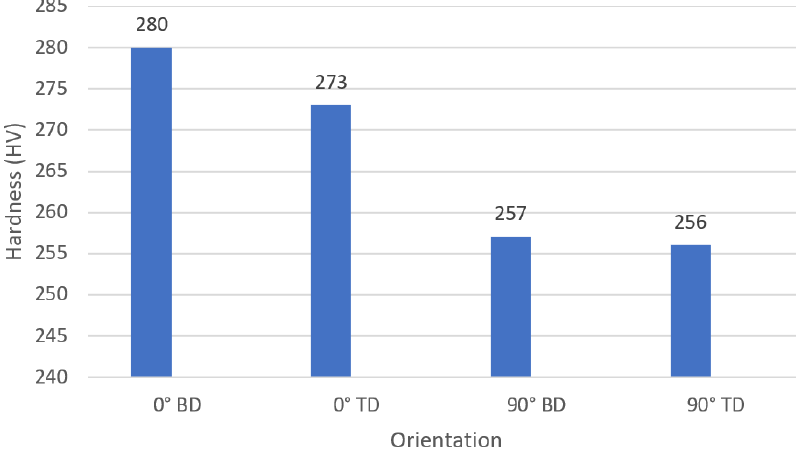
Figure 12. Hardness value for 0° and 90° build